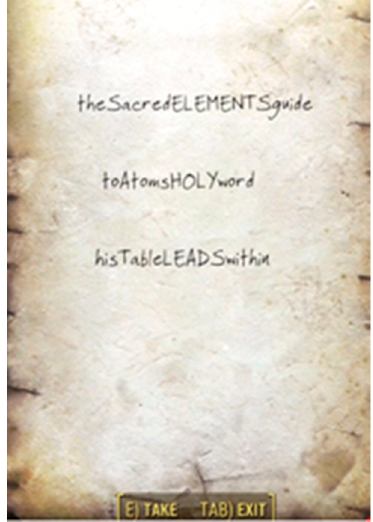
Figure 5. The scroll that guides believers to Atom’s “HOLY word.”